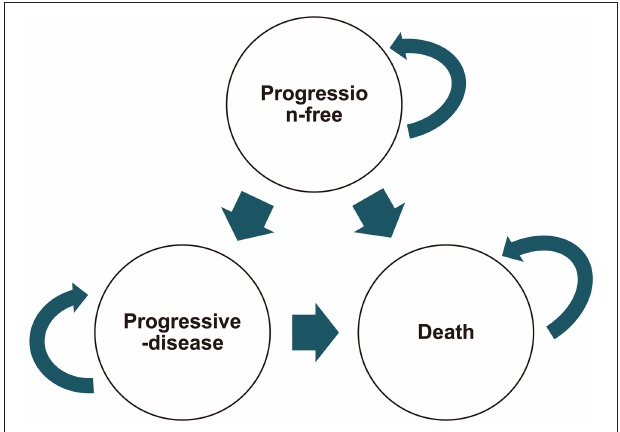
FIGURE 1 | Transition dagram for partitioned survival model health outcomes.